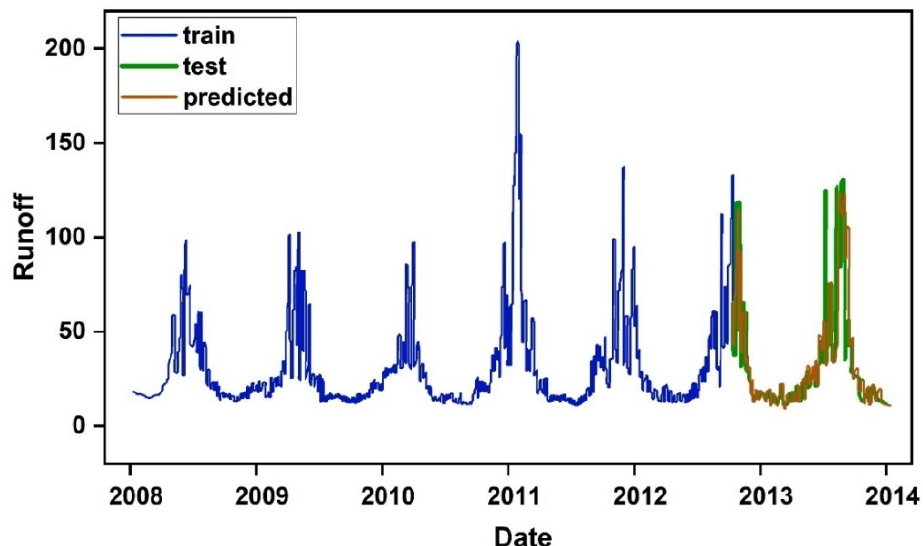
Figure 8. Loss change trend from 1960 to 2010.